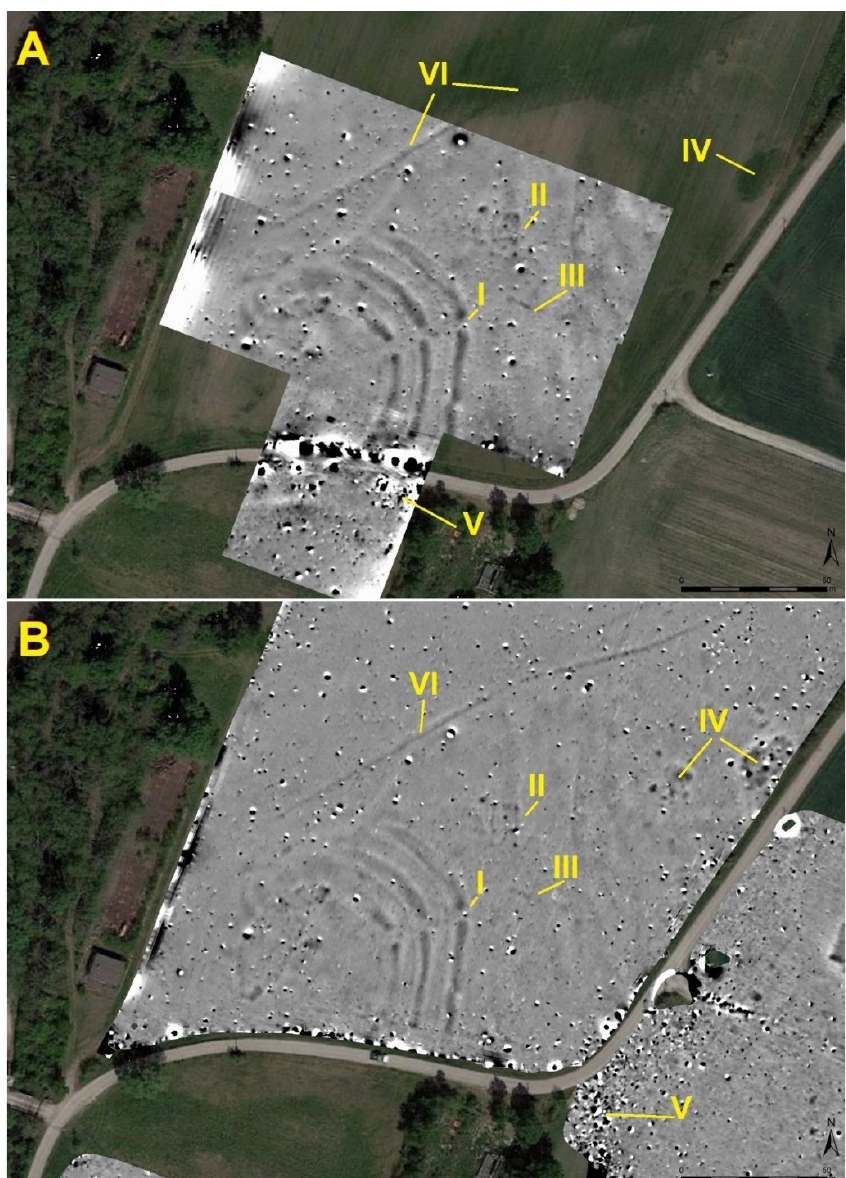
Figure 6. Comparison of the two magnetometer surveys at Velm: ( A ) the cesium gradiometer survey from 2003, and ( B ) the motorized fluxgate gradiometer survey conducted in 2015 (both with clip-off values − 4 nT to +6 nT). The Roman numerals refer to the archaeological interpretation noted in